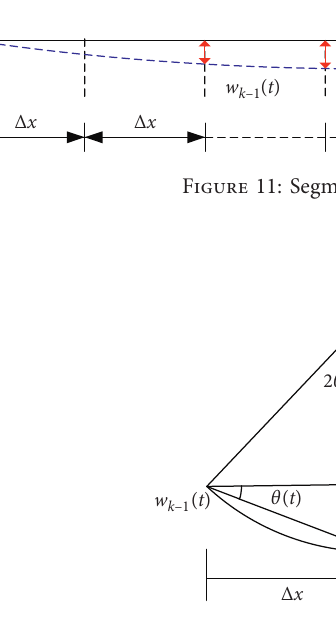
Figure 12: Geometric relationship between deflection and radius of